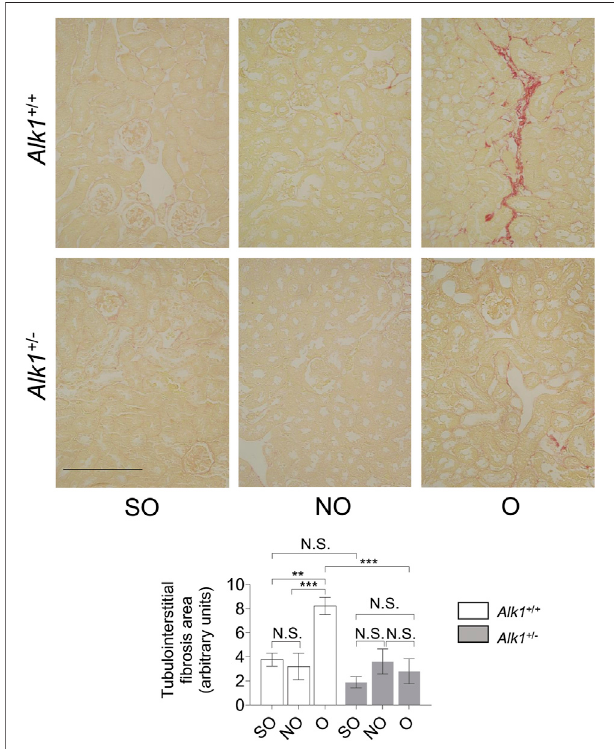
FIGURE 2 | Alk1 +/ − mice show lower kidney fi brosis after 3 days UUO. SiriusredstaininginSO,NOandOkidneysfrom Alk1 +/+ and Alk1 +/ − mice( N = 5) (upper panel). Analysis of tubule-interstitial fi brosis area in SO, NO and O kidneys from Alk1 +/+ and Alk1 +/ − mice, assessed by Fiji